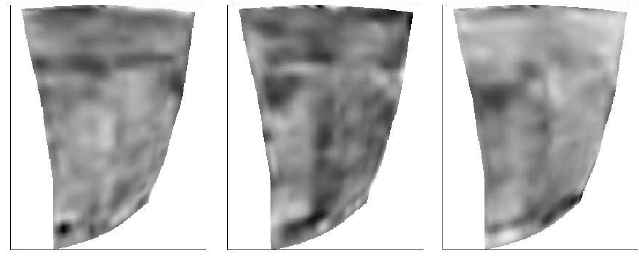
Fig. 3. Example PCA modes.